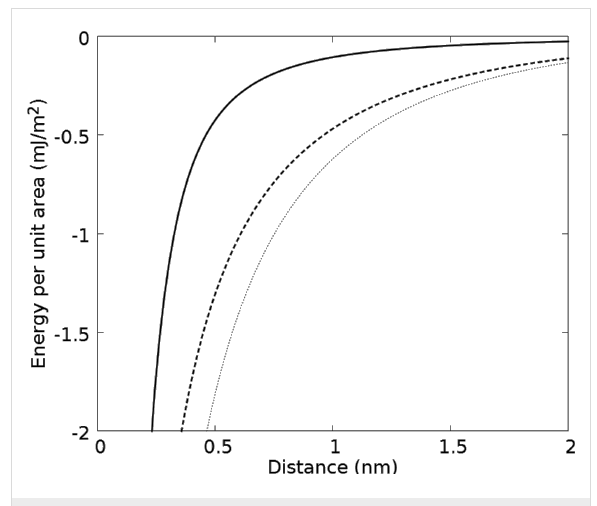
Figure 4: Expected van der Waals (solid line) and double layer (dashed line) binding energies as a function of the particle–membrane distance. The double layer interaction dominates the system for the relevant separation distances. Additionally the solution of the Hogg–Healy–Fuerstenau-equation for a cationic particle with ζ = +30 mV and a membrane with ζ = − 30 mV at l = 0.77 nm (dotted line) is